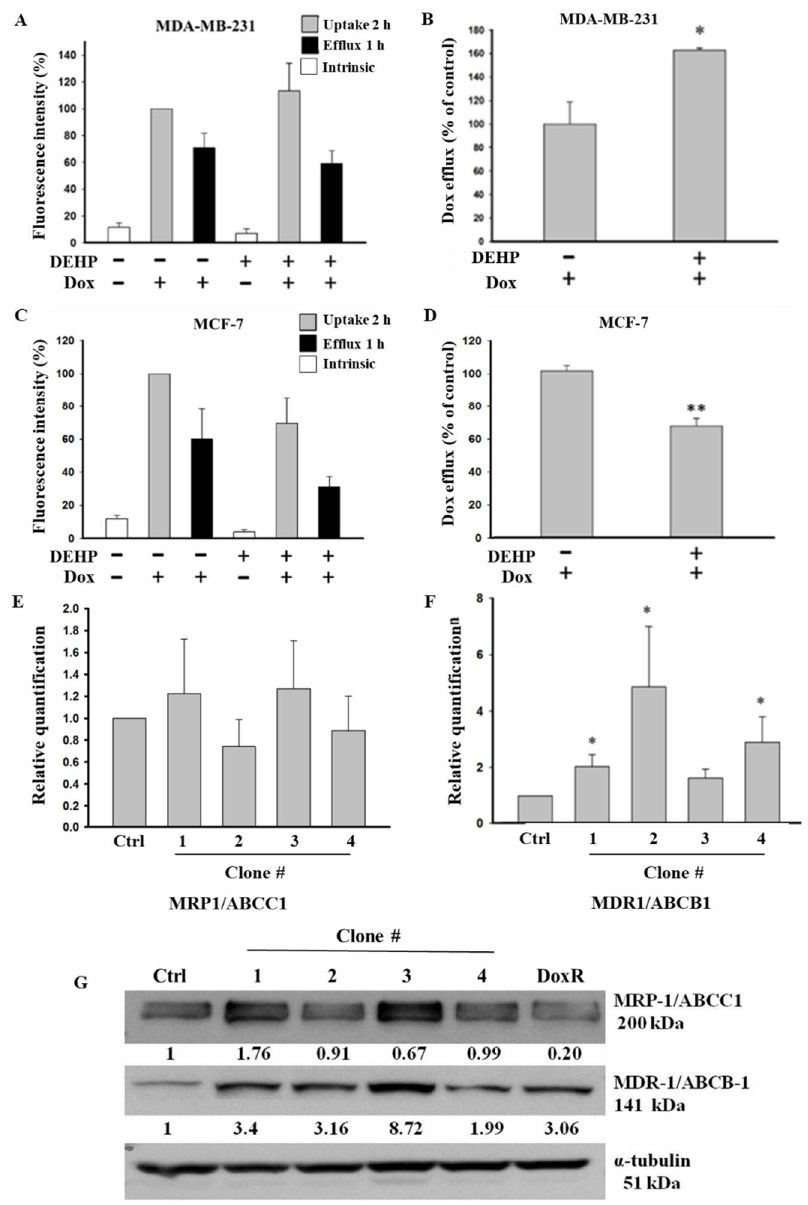
Figure 3. Quantitative results of flow cytometry analysis of drug influx and efflux in MDA-MB-231 and MCF7 cells. ( A , B ) Elevated drug influx (original and remaining) and efflux (original quantity minus remaining) were observed in DEHP-exposed MDA-MB-231 cells compared with parental MDA-MB-231 cells. ( C , D ) Decreased drug influx and efflux were observed in MCF-7 cells (parental vs. DEHP-exposed). ( E , F ) Quantitative analysis of mRNA levels showed no significant change in MRP1/ABCC1 and high MDR1/ABCB1 expression. ( G ) Representative western blot results show the overexpression of MRP1/ABCC-1 and MDR1/ABCB-1 in the long-term DEHP-exposed clones compared to the control and DoxR MDA-MB-231 cells. * p < 0.05, ** p < 0.001. (cid:4) represent Dox uptake for 2 h, (cid:4) represent Dox efflux for 1 h, (cid:3) represent intrinsic/basal fluorescence considered as background.